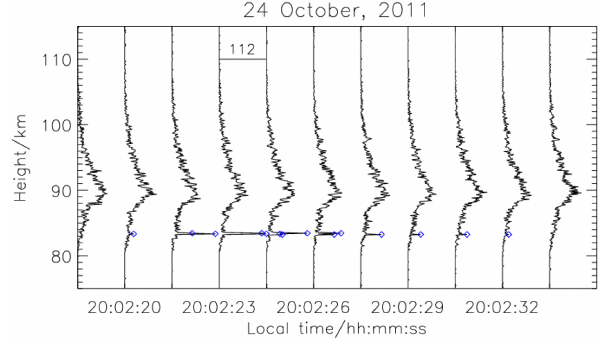
Figure 7. Evolution of a typical meteor trail observed on the bottom side of the Na layer, which occurred on 24 October 2011.